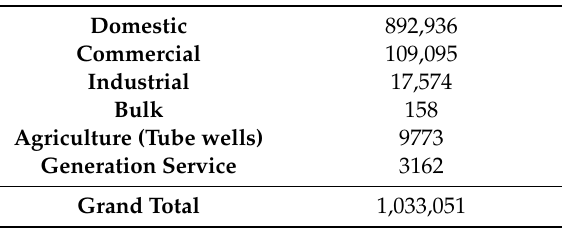
Table 1. Tari ff wise number of Table 1. Tariff wise number of consumers.